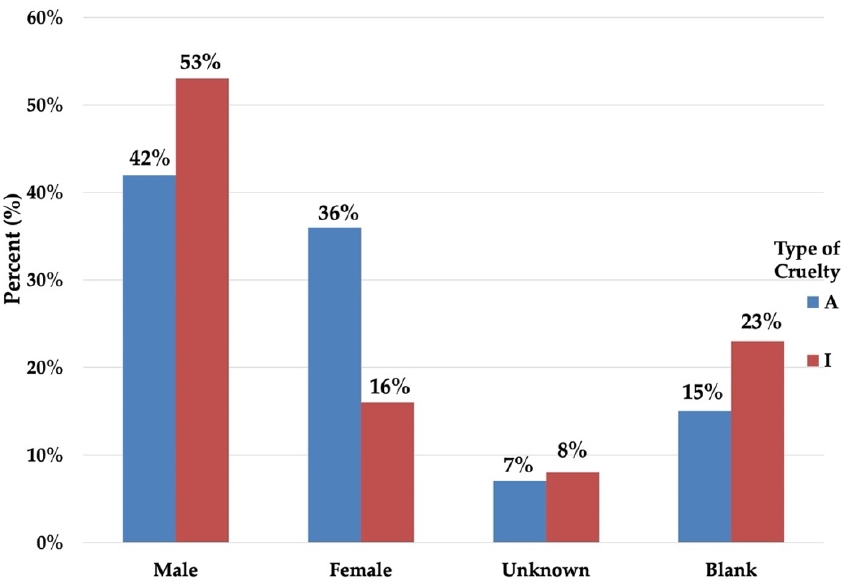
Figure 8. Gender of Animal Cruelty Offenders for Neglect (A) and Intentional Abuse (I).